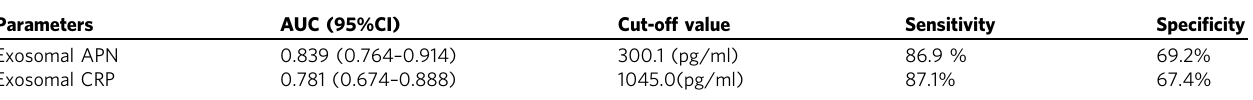
Table 2 The predictive performances of exosomal APN and CRP